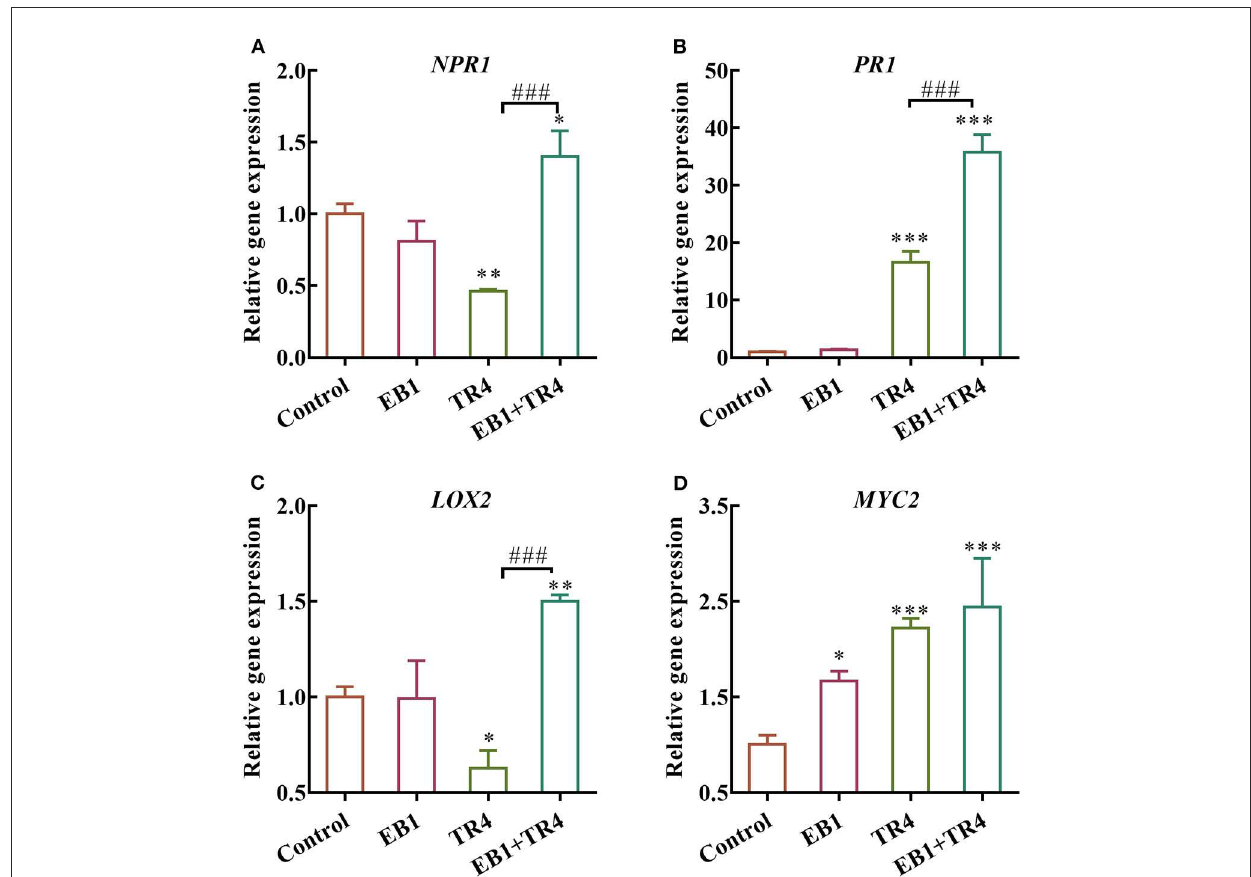
FIGURE5 Effects of strain EB1 and TR4 inoculations on the expression of defense genes. The expression patterns of (A) NPR1 , (B) PR1 , (C) LOX2 , and (D) MYC2 were analyzed by RT-qPCR. All data are expressed as the mean ± SD ( n = 4). * p < 0.05, ** p < 0.01, and *** p < 0.001 indicate significant differences between treatment groups and control group. ### p < 0.001 indicate significant differences between treatment